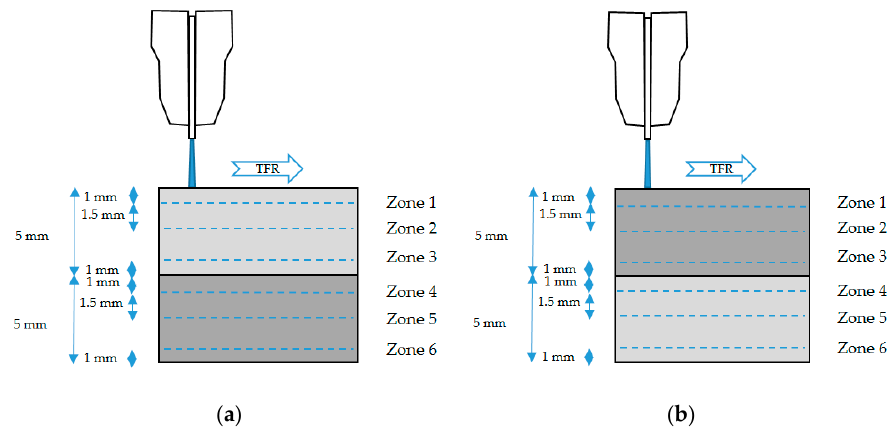
Figure 4. Schematic representing the roughness measurement zones and the distance between them for: ( a ) UNS A97075/CFRP configuration; ( b ) CFRP/UNS A97075 configuration.